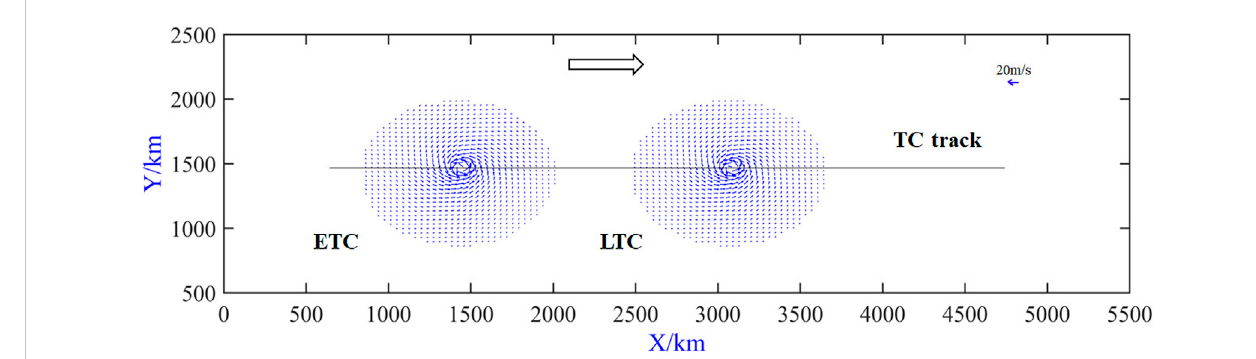
FIGURE 7 The schematics of simulations for sequential